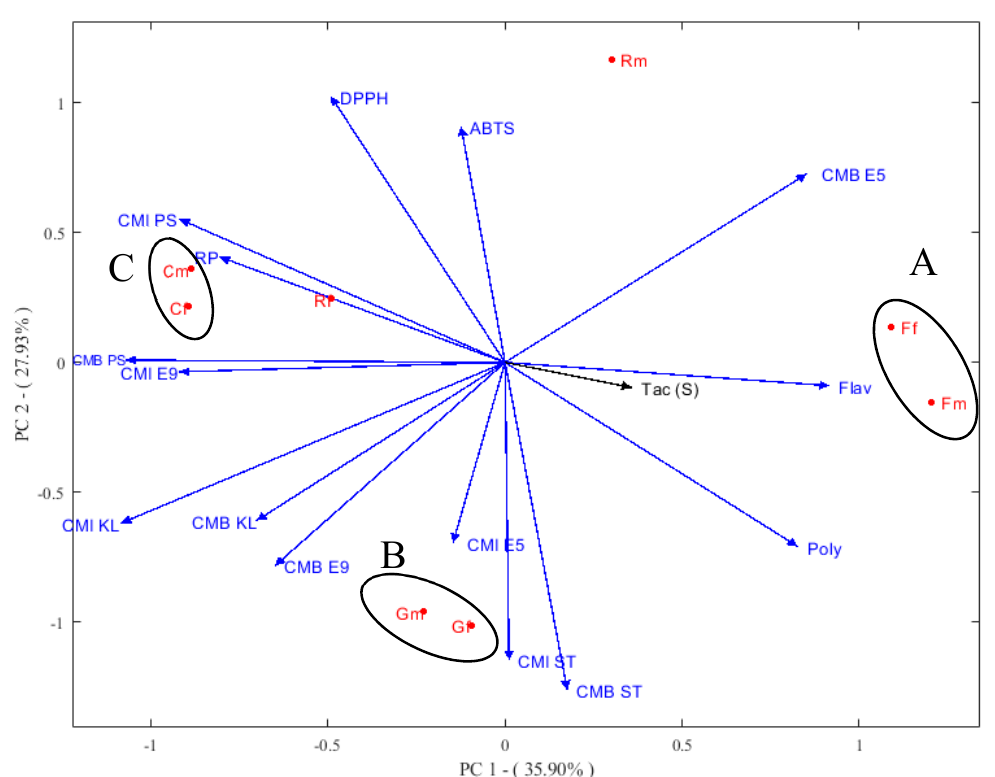
Figure 2. Analysis of the main components of antioxidant and antibacterial activities (poly: total polyphenol; Flav: flavonoid; TAC: total antioxidant capacity; DI: diameter inhibition; E5: E. coliB6N ; E9: E. coli BGM ; KL: Klebsiella pneumonia ; PS: Pseudomonas aeruginosa ; ST: Staphylococcus aureus , Rm: roots of A. P var. pyrethrum ; Gm: seeds of A. P var. pyrethrum (L.); Fm: leaves A. P var. pyrethrum (L.); Cm: capitula of A. P var. pyrethrum (L.); Rf: roots of A. P var. depressus (Ball) Maire; Gf: seeds of A. P var. depressus (Ball) Maire; Ff: leaves of A. P var. depressus (Ball) Maire; and Cf: capitula of A. P var. depressus (Ball) Maire) .